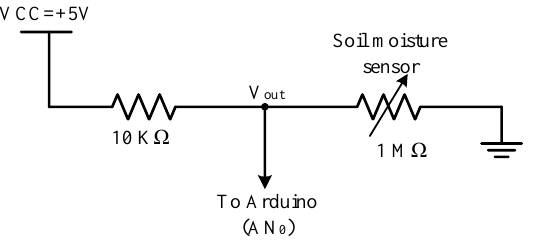
Figure 7. Circuit diagram of the soil moisture sensor.